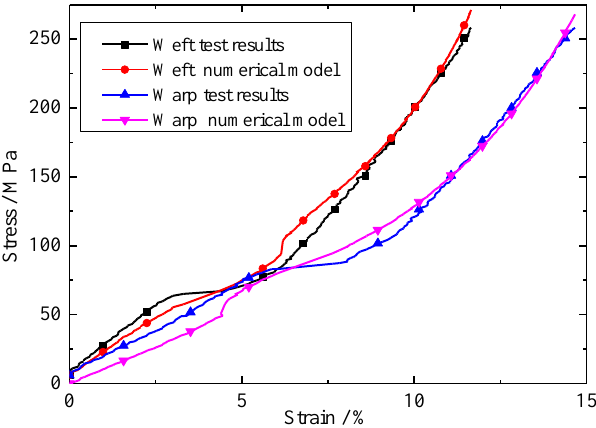
Figure 8. Comparison of test results and numerical models with a stress ratio of 1:1 (warp:weft).